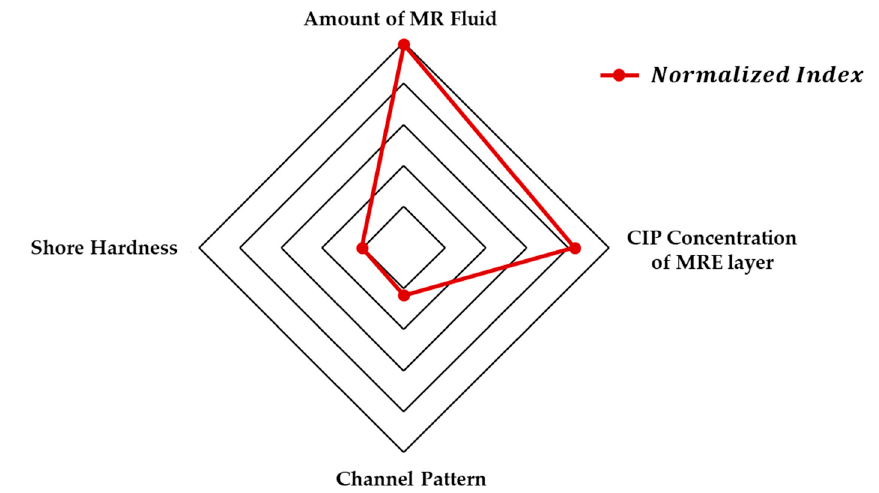
Figure 13. Radar chart of each parameter.